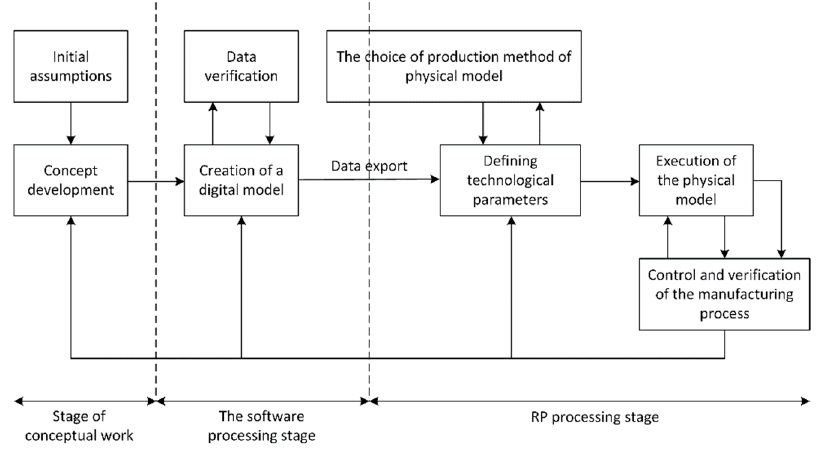
Figure 3. Diagram of the rapid prototyping process [12].